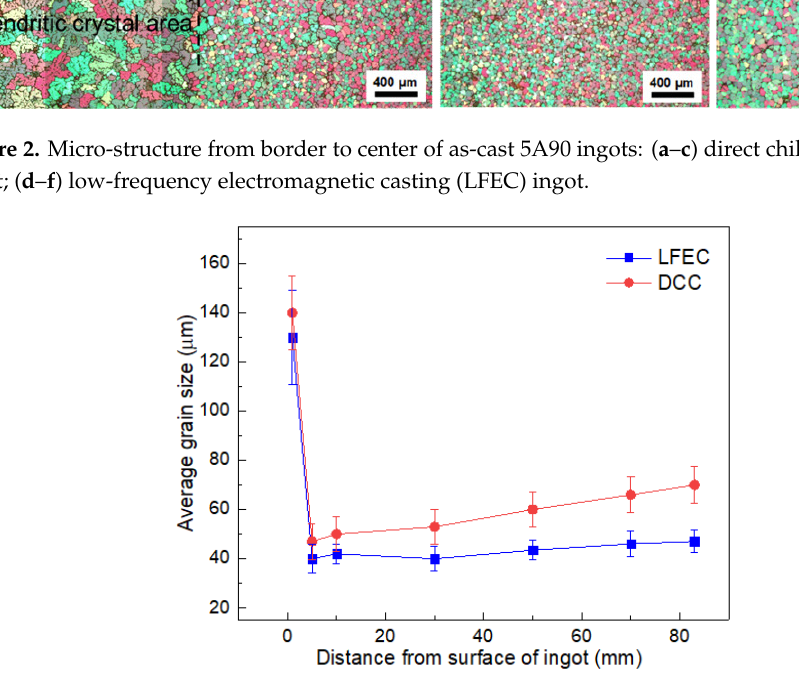
Figure 3. Statistic data of grain size of ingots.